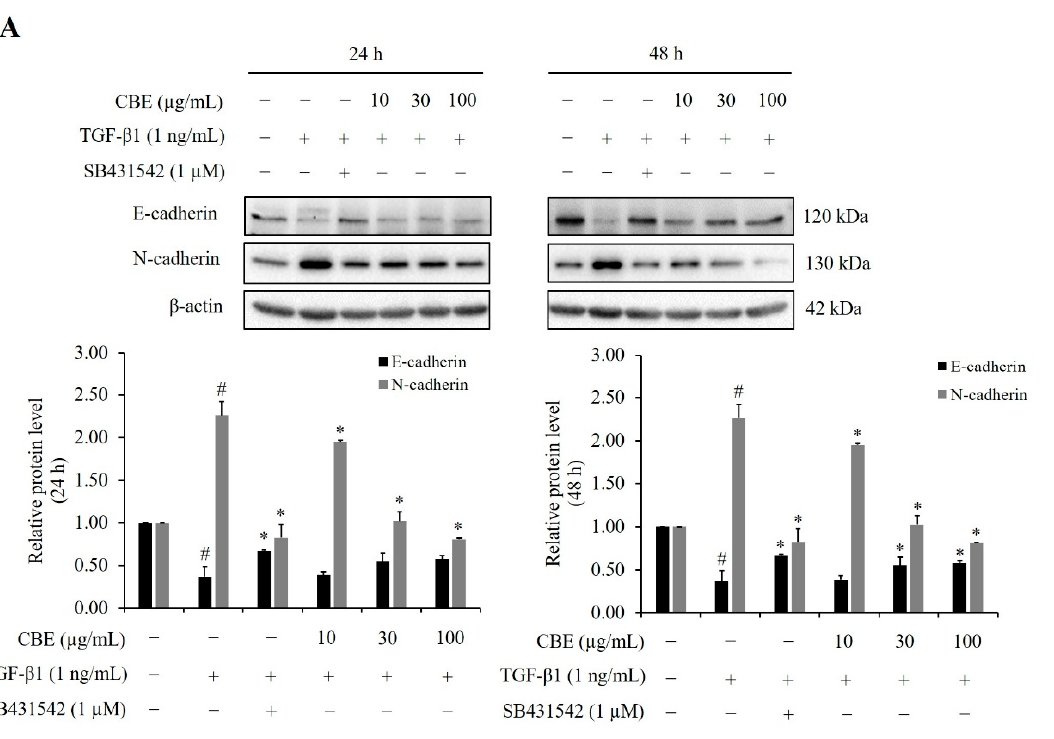
Figure 3. Effect of CBE on reversion of TGF- β 1-induced morphological changes in LoVo cells. Cells were pre-treated with CBE and SB431542. After incubation, cells were treated with TGF- β 1 for 24 and 48 h. Cell morphology was observed under a microscope. CBE, Cinnamomum bejolghota extract.